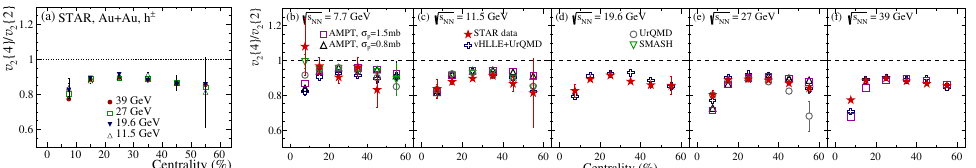
Figure 3. Centrality dependence of the v 2 { 4 } / v 2 { 2 } ratio of charged hadrons from Au+Au collisions √ s NN = 39–11.5 GeV ( a ) measured in STAR [13], and its comparison with vHLLE+UrQMD, AMPT at √ s NN = 7.7–39 GeV ( b – f ). SM, UrQMD and SMASH models at √ s NN = 7.7 and 11.5 GeV. On the one UrQMD, AMPT SM, and vHLLE+UrQMD models at